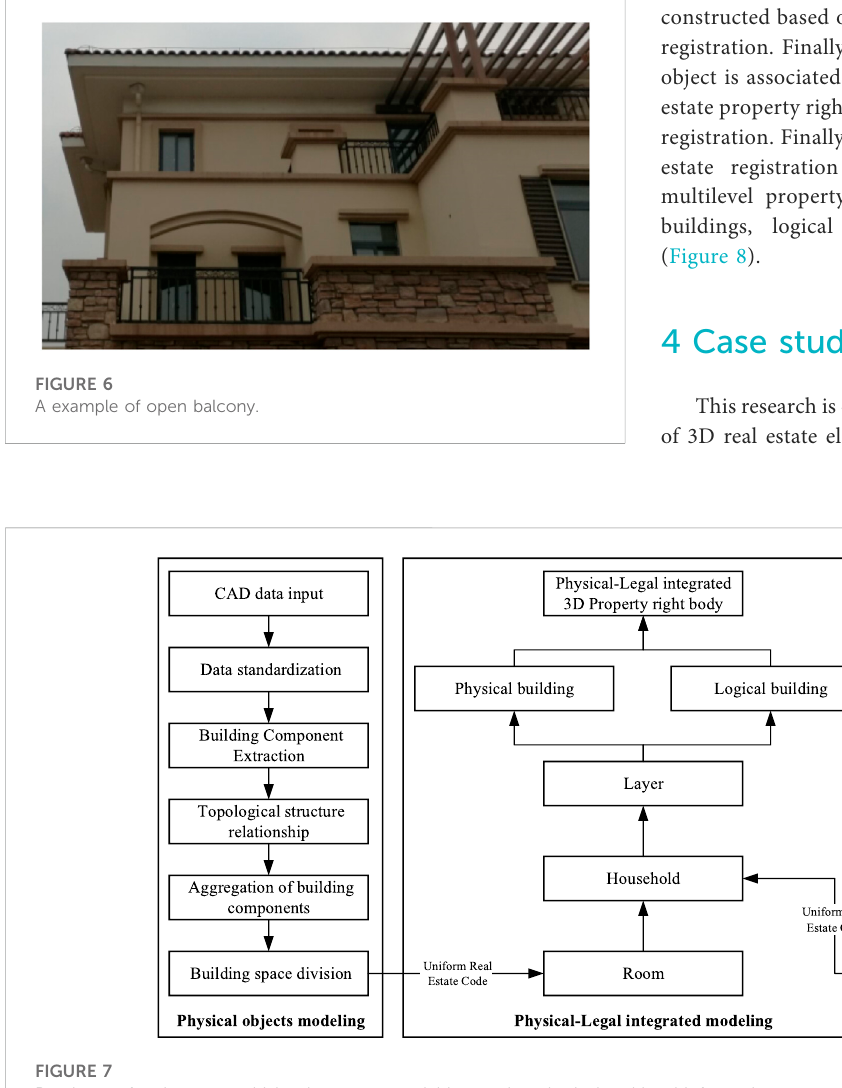
Frontiers in Earth